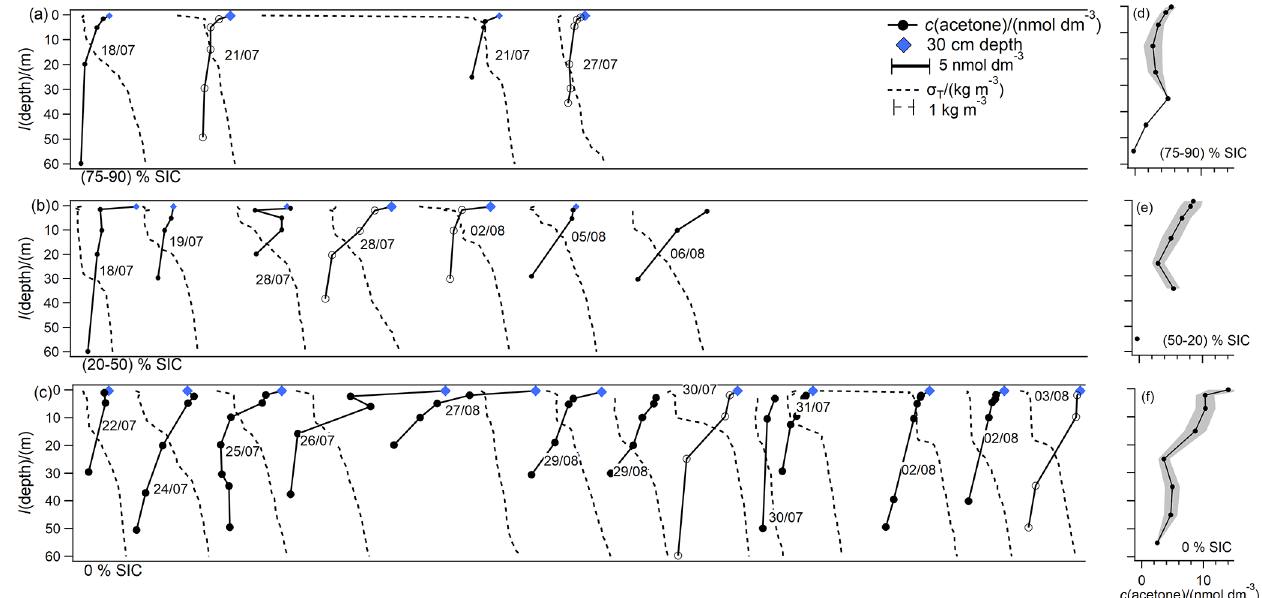
Figure 3. Overview plot displaying the shape of all acetone and density ( σ T ) depth profiles, grouped by SIC and staggered along the x axis for ease of viewing. Panel labels indicate the SIC bin. The scale bars for acetone and density in (a) also apply to (b) and (c) . Profiles with hollow markers are highlighted in Fig. 7. Sampling dates are indicated to locate stations using Fig. 1. Panels (d) to (f) indicate absolute concentrations of mean vertical profiles grouped according to ice cover and binned by depth horizons. The shaded area indicates standard error for each depth